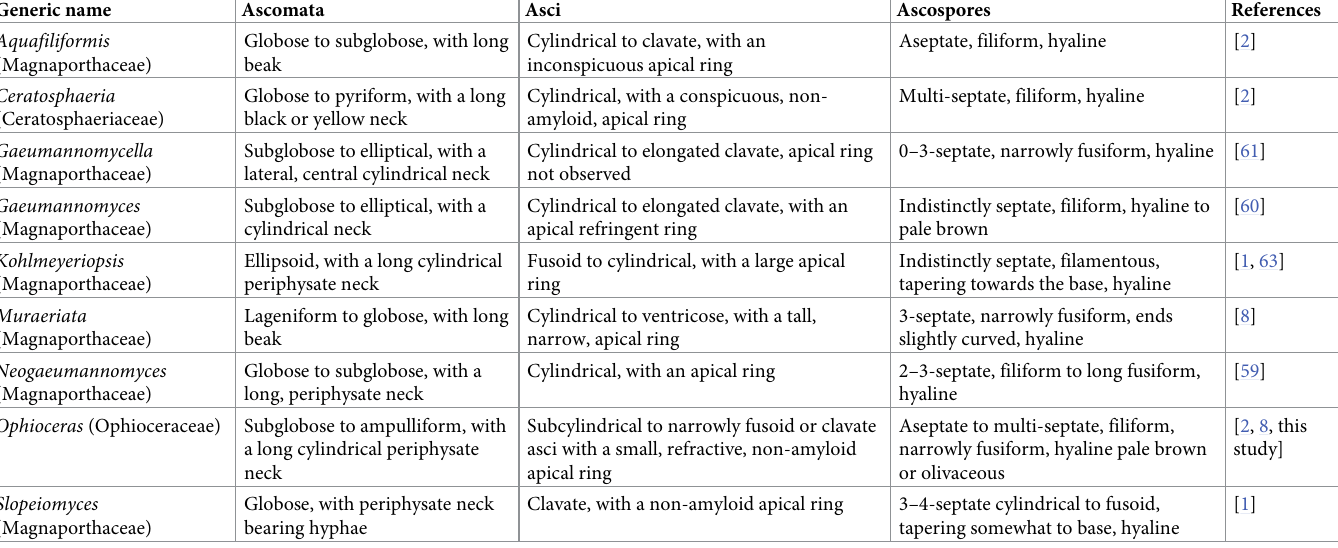
Table 3. Morphological comparisons of similar genera to Ophioceras